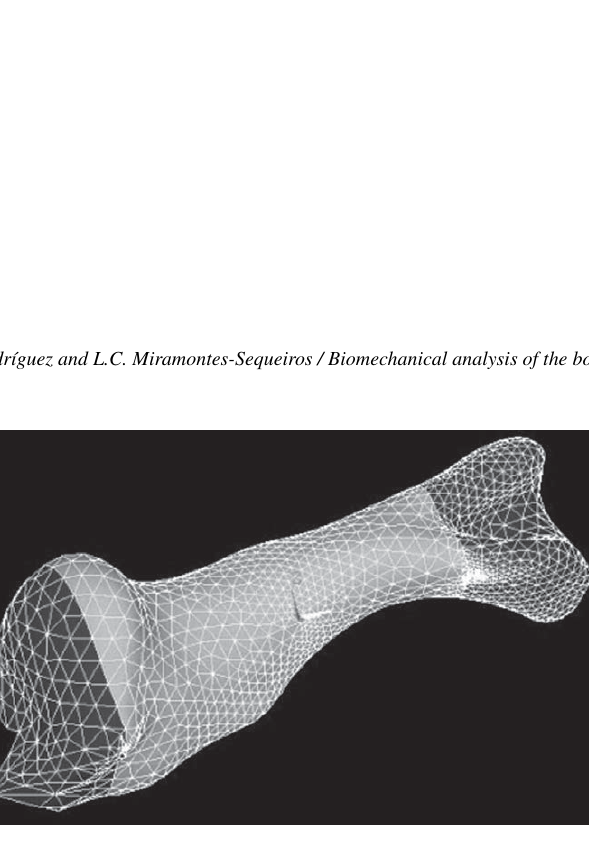
Fig. 4. External contour of finite element resultant